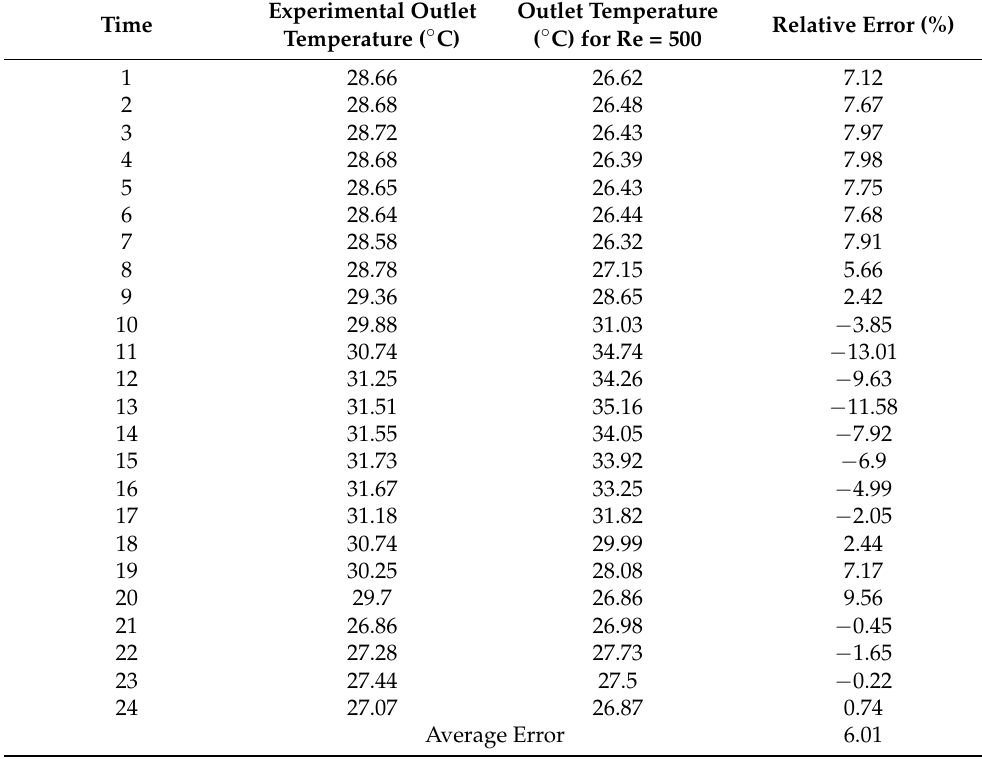
Table 7. Comparison of experimental vs. modeled outlet temperature for 30 July 2016 (1 m